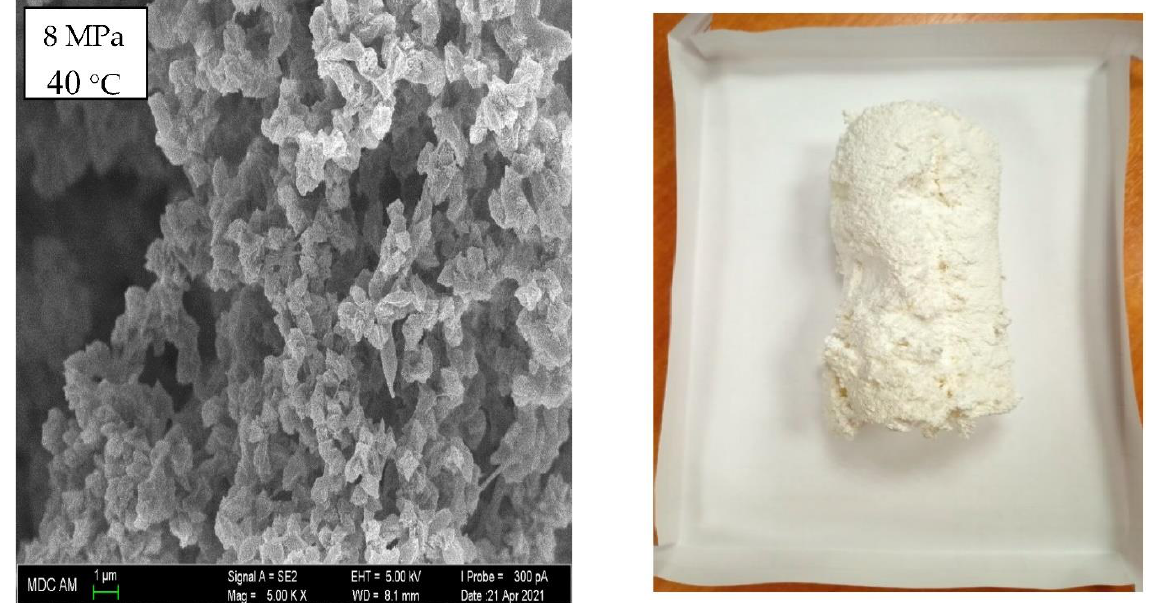
Figure 2. SEM image (phase morphology, left ) of the polymer blend microparticles with a composition of PP-01030 (75%)/EPTSR-50 (25%) and photo ( right ) produced by SEDS at a temperature of t = 40 °C and pressure Р = 8 MPa (see Table 3, operating condition No. 3).